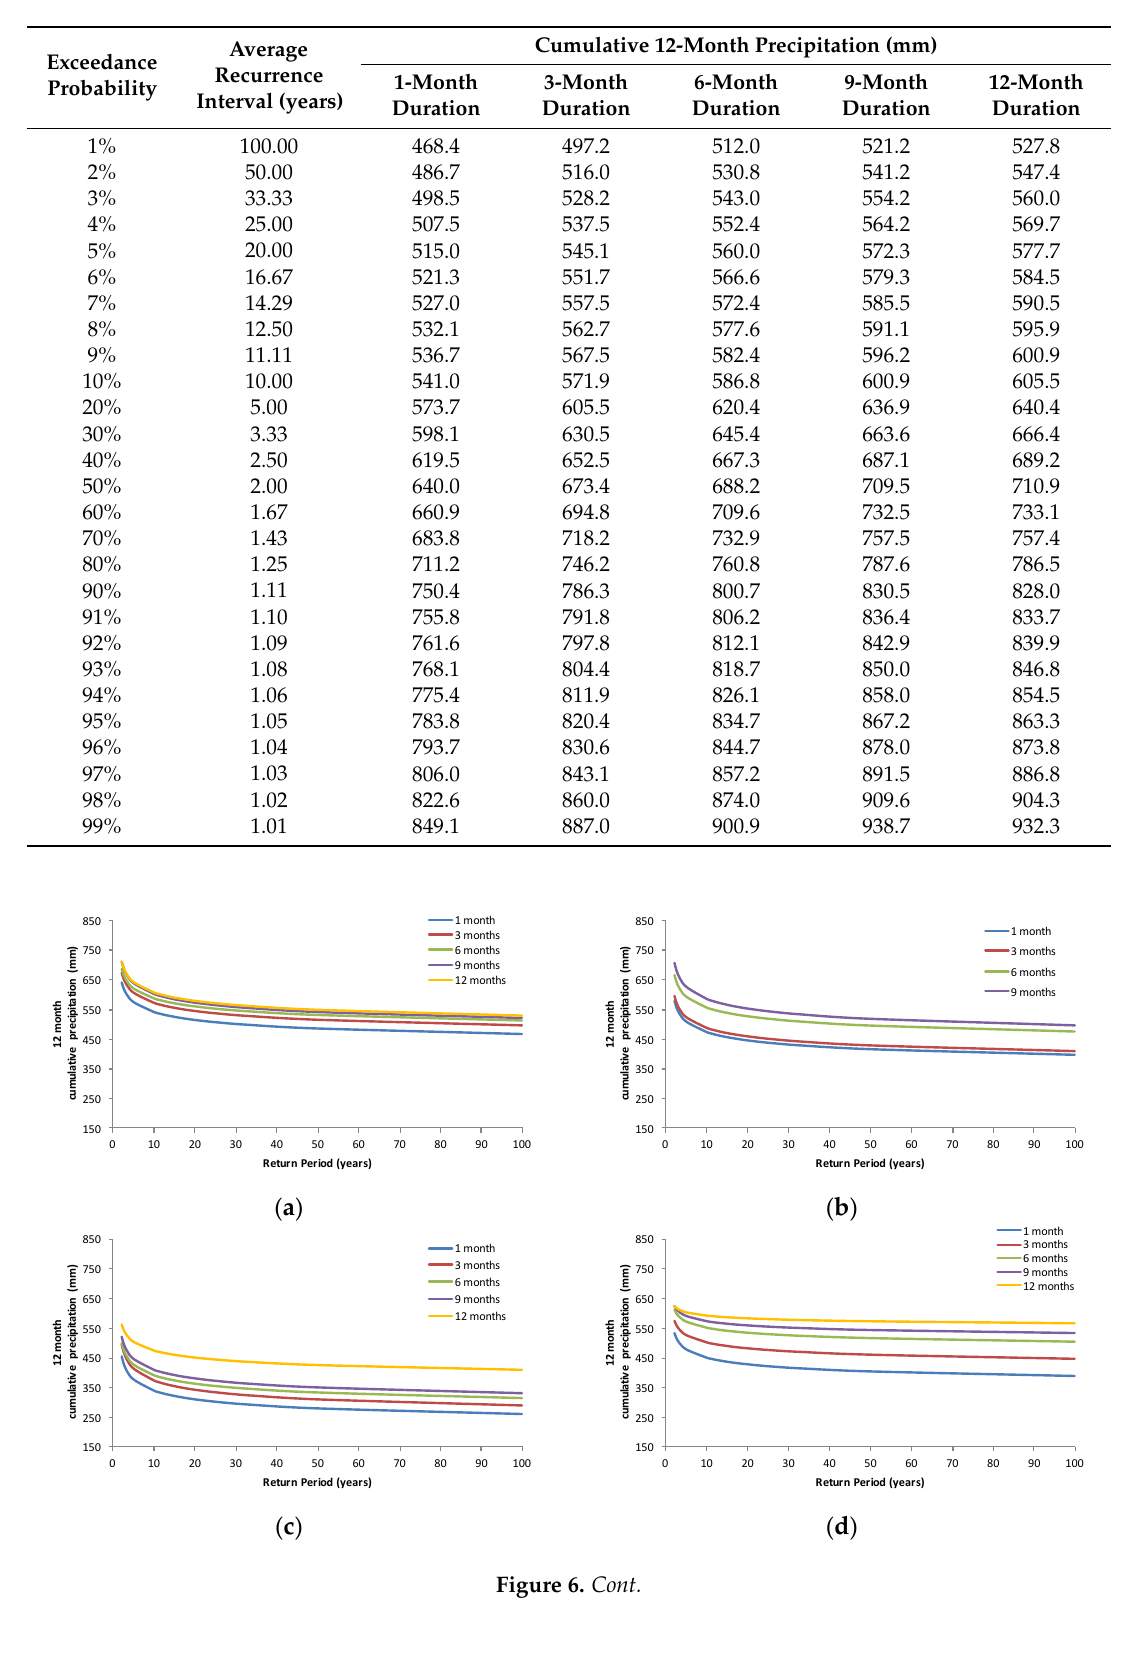
Table 4. Fitted gamma distribution for S ã o Francisco Station.